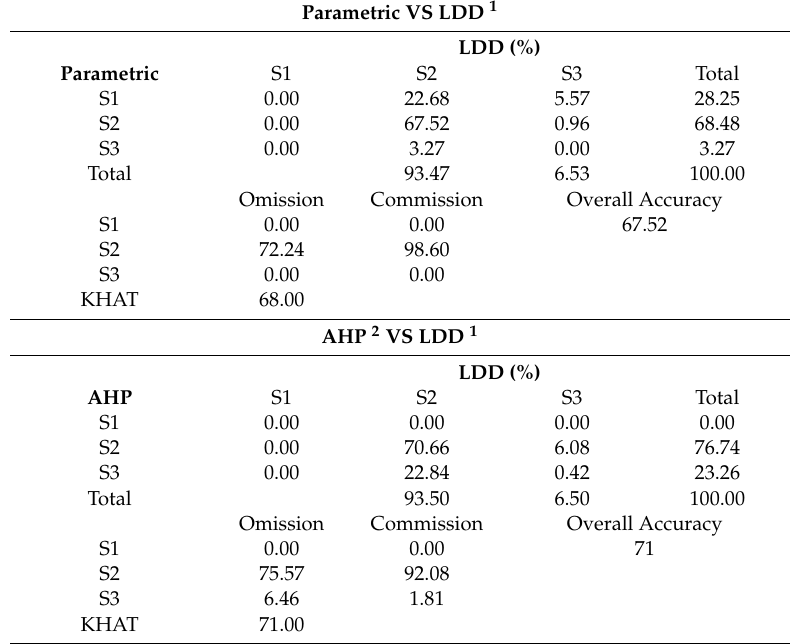
Table 11. Error matrix comparing the results of the Land Development Department in Thailand (LDD) and the results from the study by each